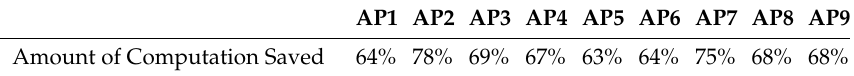
Table 3. Reduction in the amount of computation for each access point (AP) from Figure 5 .